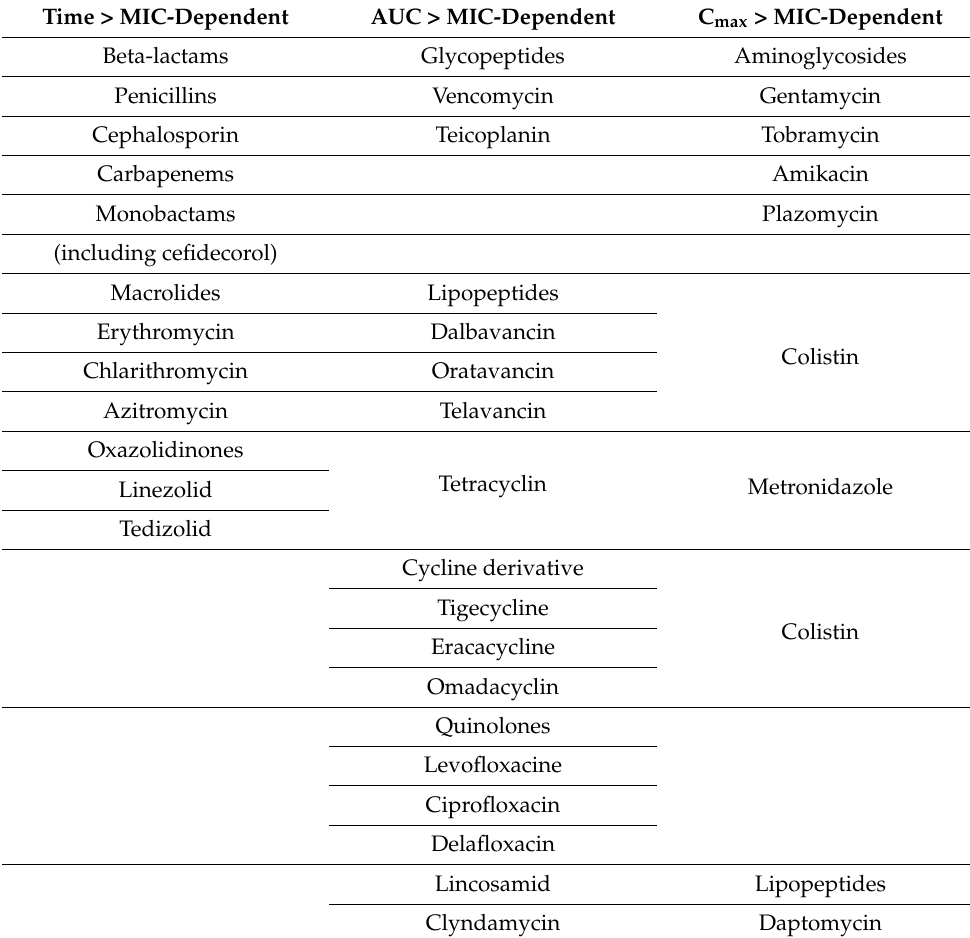
Table 3. Properties and Pk/Pd targets of the main antimicrobial drugs.